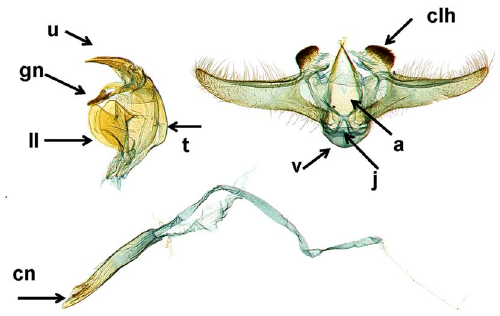
Figure 1. Male genitalia of Diatraea saccharalis . Adult male collected in Avoyelles, Louisiana from sugarcane by R T Richard. Adult is deposited in the National Museum of Natural History, Smithsonian Institute, Washington DC (USNM Slide # 112, 735). Terminology is from Dyar and Heinrich (1927), an=anellus, chl=basal projection lobe from costa of harpe, cn=cornatus (or cornuti) of penis, gn=gnathos, j=juxta, ll=lateral lobe of tegumen, t=tegumen, u=uncus, v=vincu- lum. Photo edited by M Metz and M A Solis.